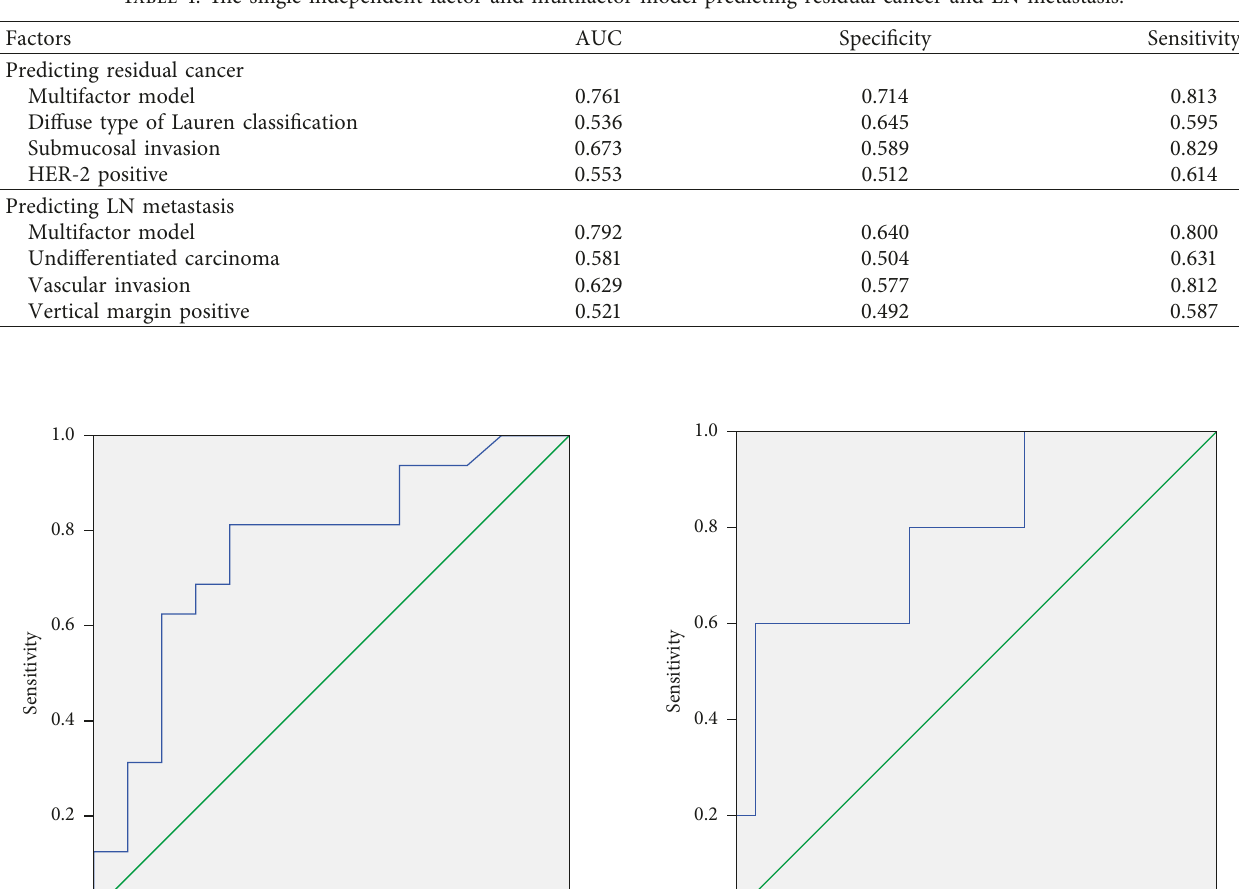
Table 4: The single independent factor and multifactor model predicting residual cancer and LN metastasis.